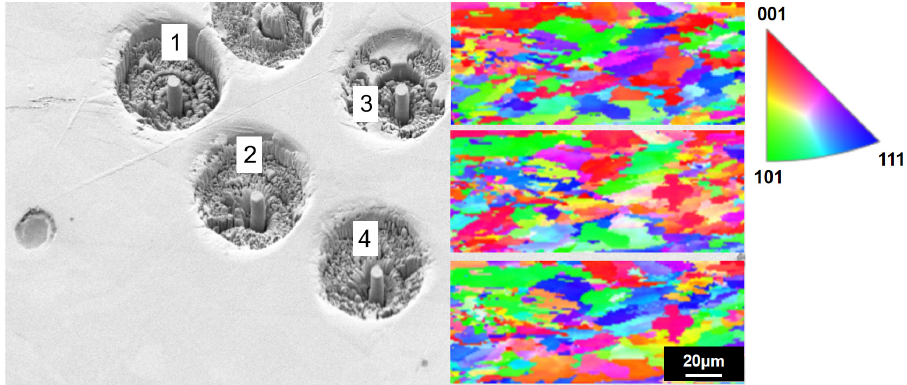
Figure 10. Micro-area SEM and IPF images of SLM HEA FIB cone structure sampling (note: the FIB sampling section is parallel to BD and FIB sampling as random polycrystalline microdomains).